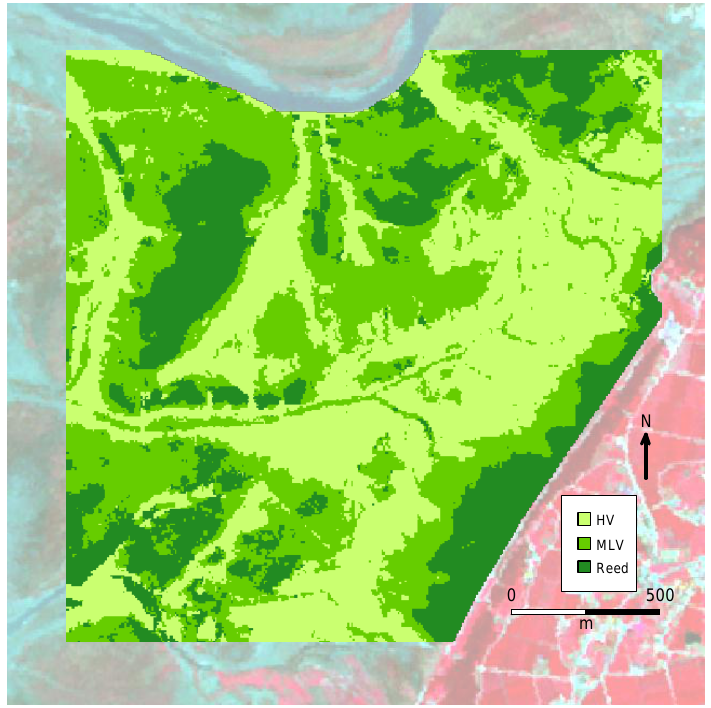
Figure 10. Classification map by the RF model 6 (126.60°E, 35.73°N).